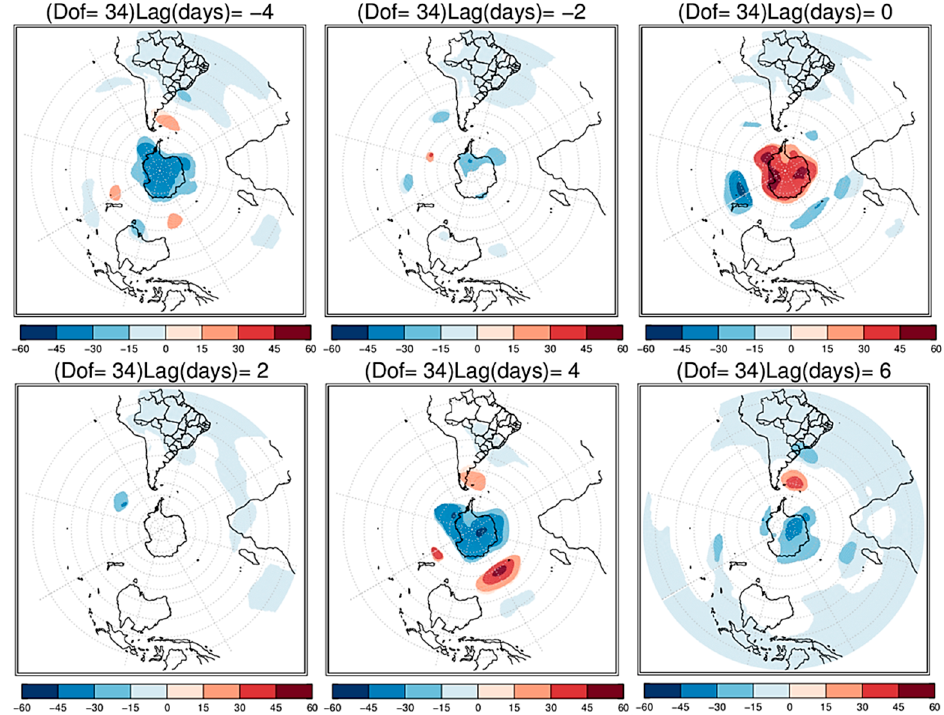
Figure 11. The same as Figure 10 but for AAO −